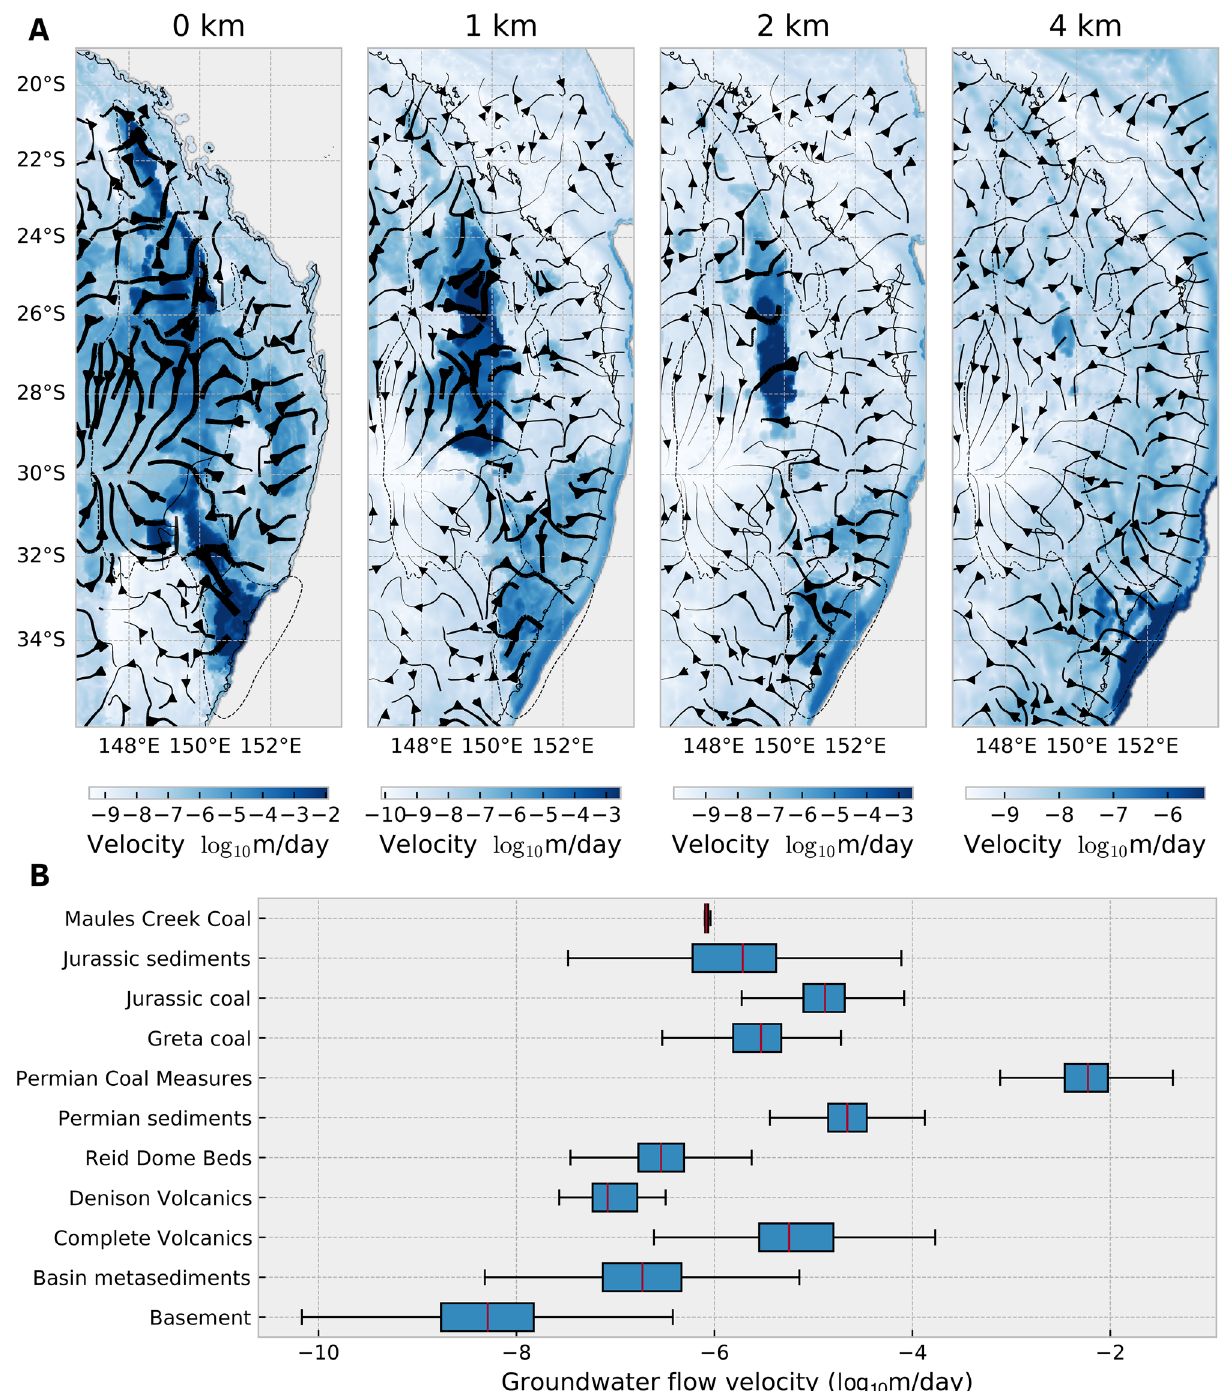
Figure 8. ( A ) Depth slices through the Sydney-Gunnedah-Bowen Basin showing the groundwater flow velocity in log 10 m/day. Streamlines indicate the direction of horizontal flow, their thicknesses are proportional to the magnitude of velocity. The dashed outline indicates the spatial extent of the SGB Basin. This map was generated from our models using Cartopy 0.19 (https:// scito ols. org. uk/ carto py). ( B ) Box plot of the groundwater flow velocities through various layers within the model. Due to the depth-dependent hydraulic conductivity, there is generally a reduction of groundwater flow velocities at greater